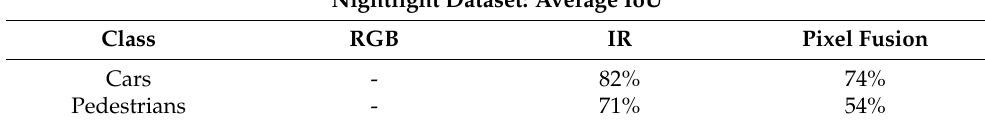
Table 4. IoU classification scores of networks trained with only nightlight images. Different types of images (IR and fused) was used for each training process. Results specify the average IoU scores in detecting and correctly classifying cars and pedestrians by the trained network compared to GT